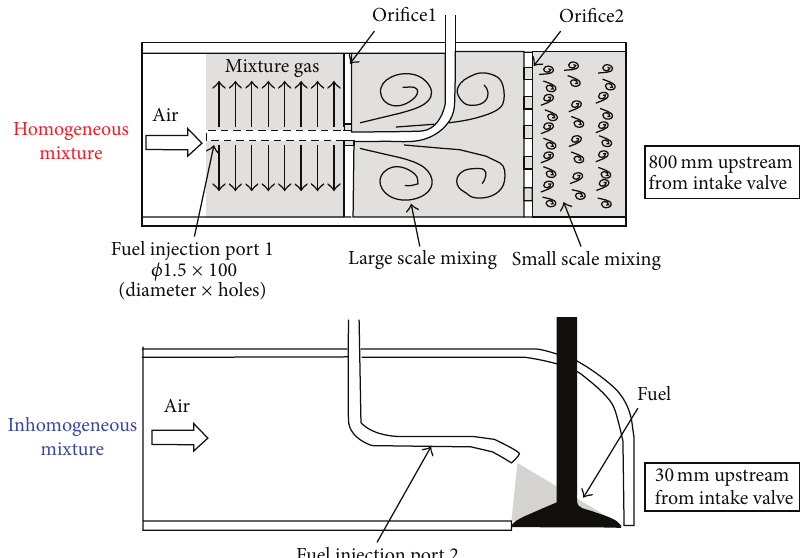
Figure 1: The different mixing process in the manifold [8].